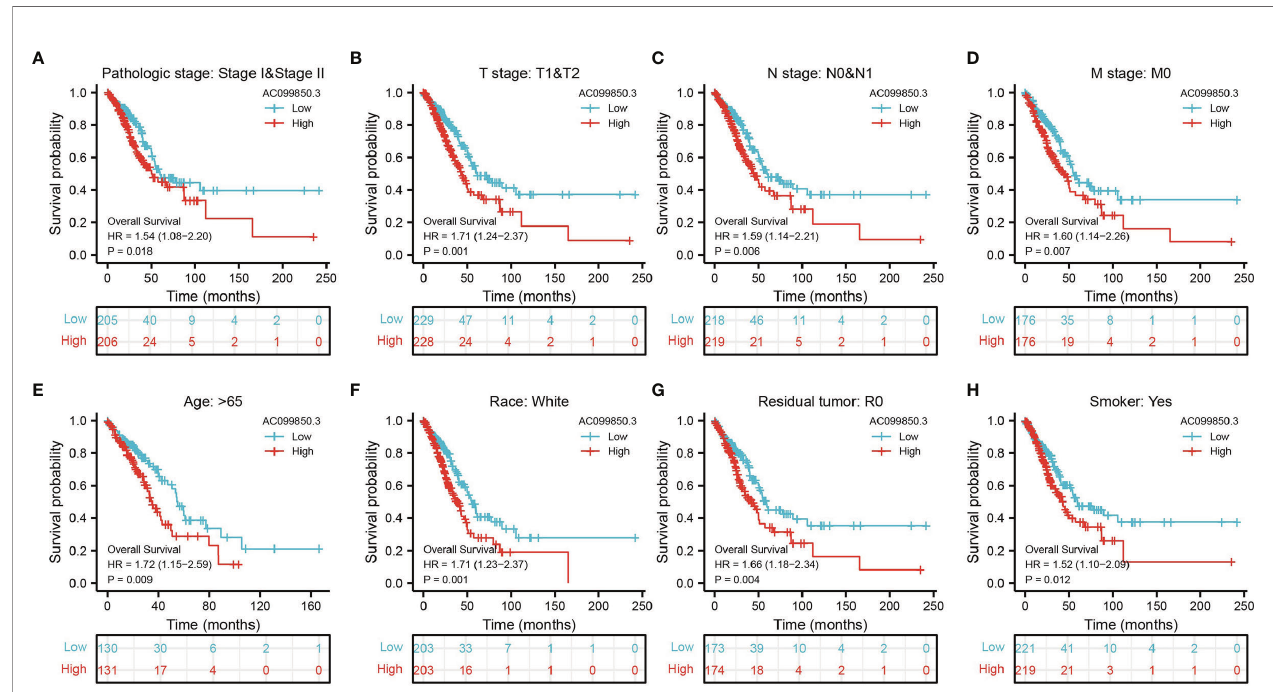
FIGURE 4 | The OS of AC099850.3 based on diverse subgroup. (A – H) The OS of AC099850.3 based on diverse subgroup, including the stage I and II, T1 and T2, N0 and N1, M0, age >65, White, residual tumor: R0, and smoker.